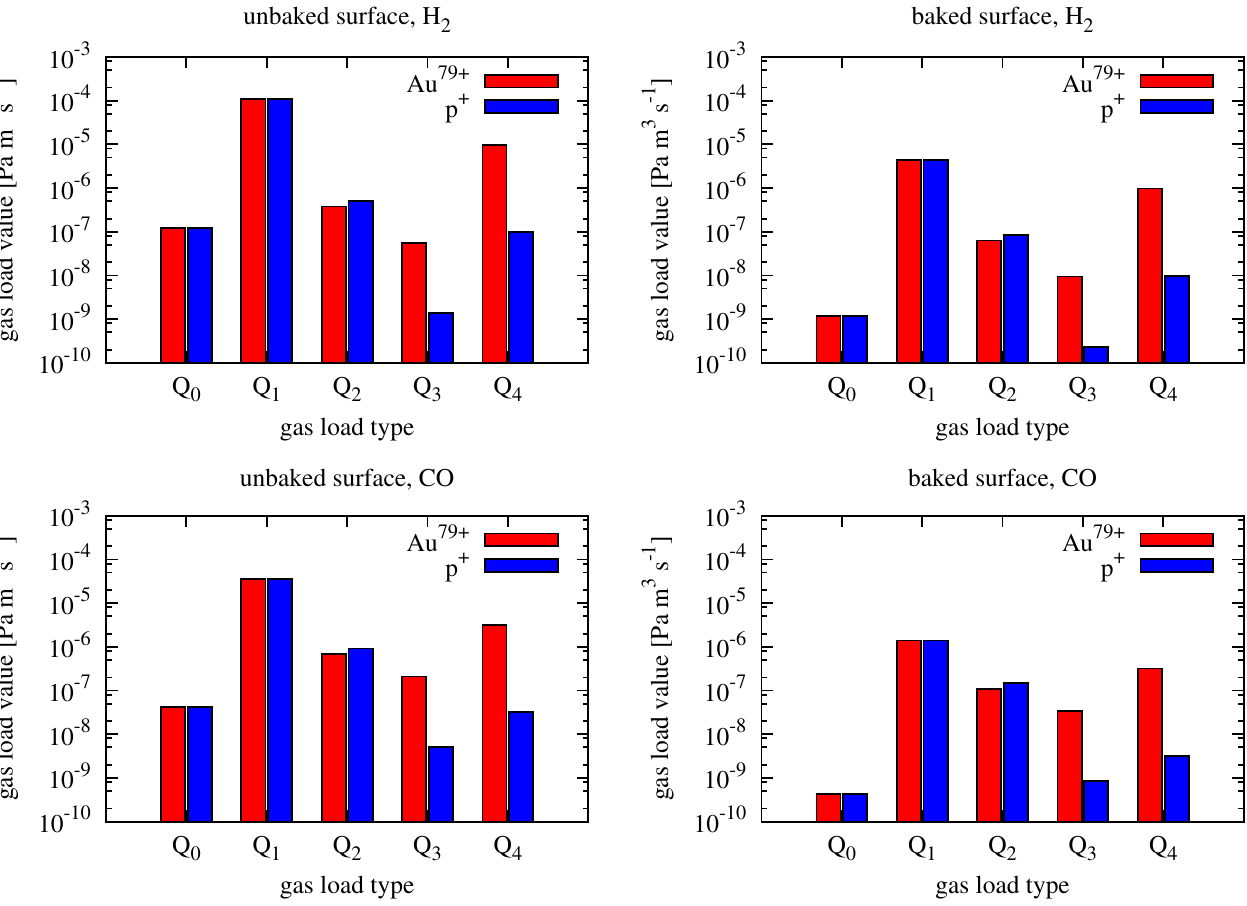
FIG. 2. (Color) Comparison of gas loads due to various effects. This figure is a summary of the gas load calculations presented in Tables II, III, IV, V, and